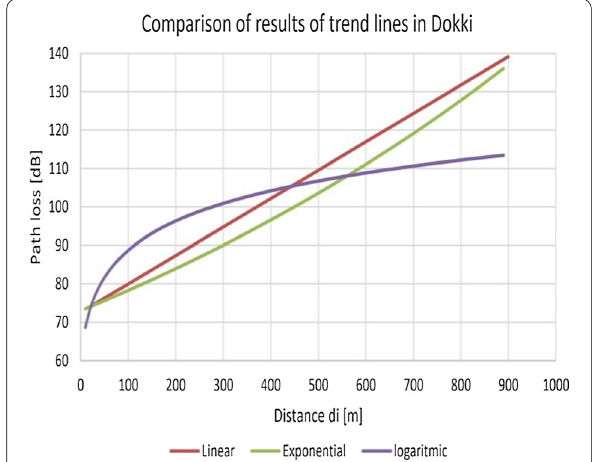
Fig.10 Comparison of results of trend lines in